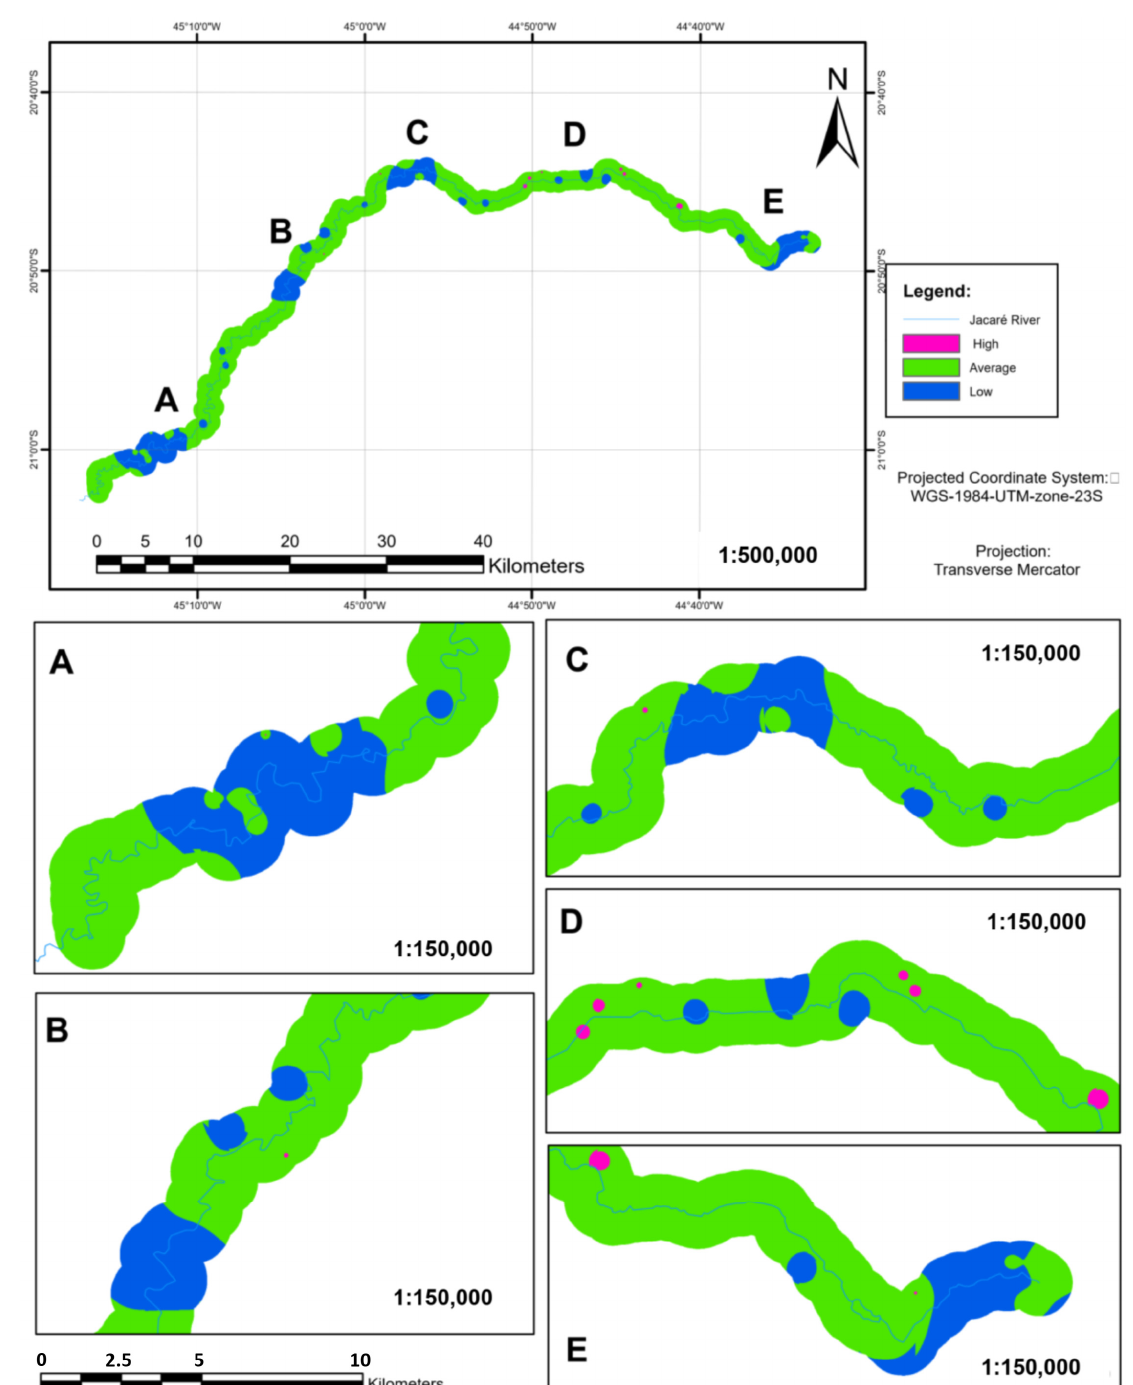
Figure 11. Map of the vulnerability of adjacent forest fragment to the reforestation sites. ( A – E ) are the regions with the most significant potential for reforestation.